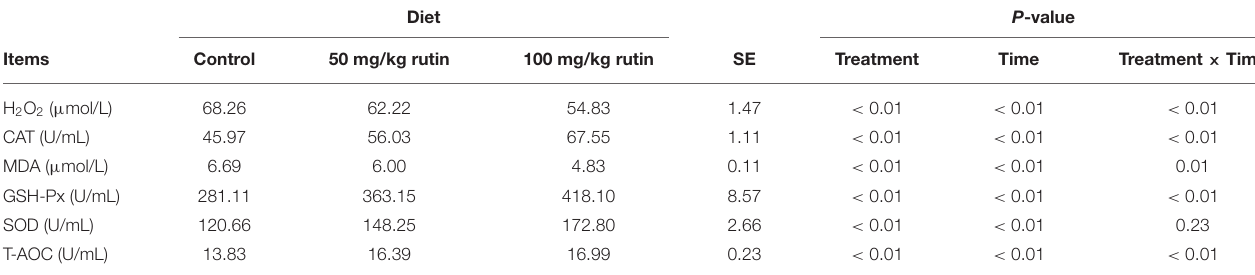
TABLE 5 | Effects of rutin supplementation to Hu sheep from − 14 through 28 d around parturition on biomarkers of oxidative stress. Diet P